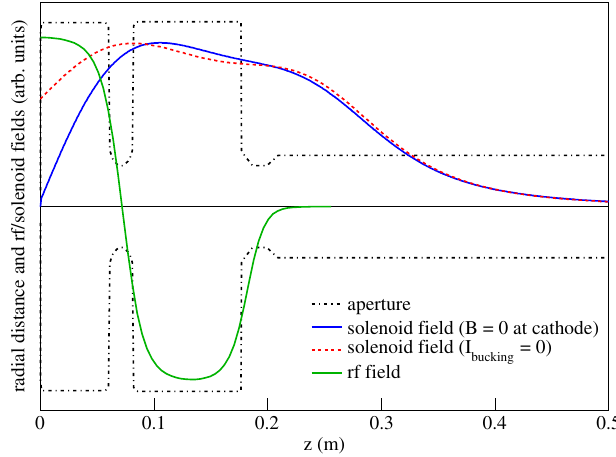
FIG. 1. (Color) Schematic view of the FNPL gun. The rf power for electron beam acceleration is fed into the gun through the side coupler connected to the full cell of the gun cavity. Three solenoids focus the electron beam in order to preserve the emittance. The primary and secondary solenoids have the same polarity, opposite that of the bucking solenoid.